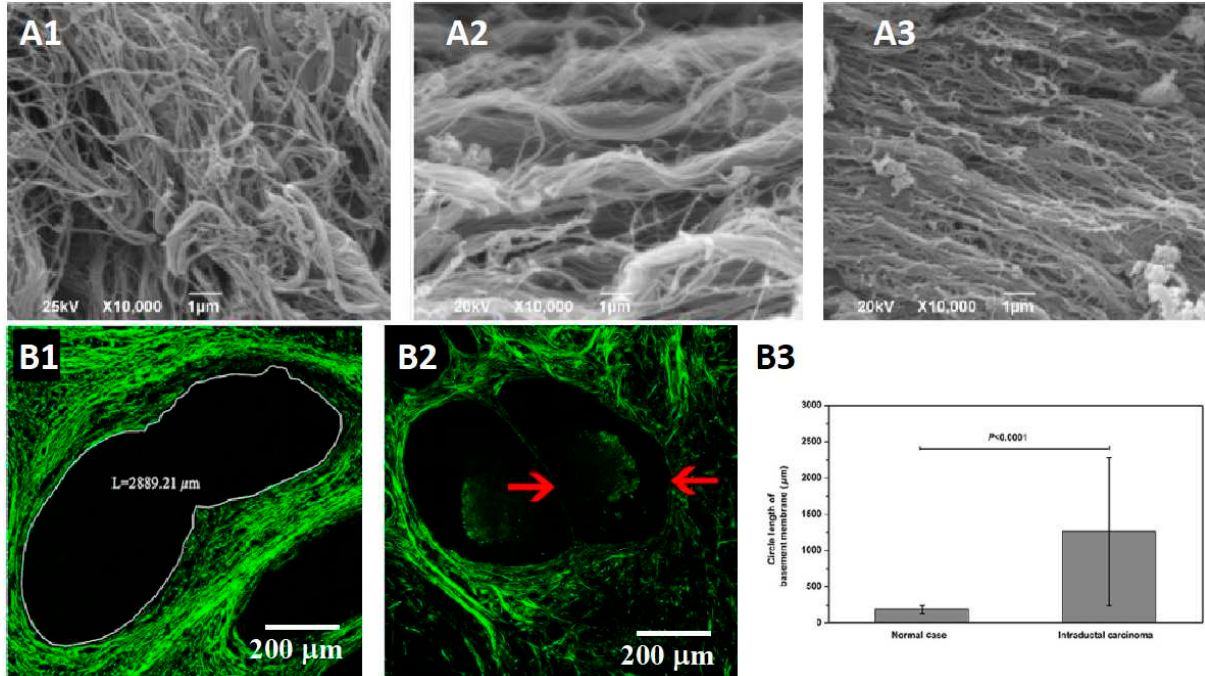
Figure 2. Collagen remodeling in precancerous lesions is a signal of cancerization. ( A1 – A3 ) The SEM images of collagen fibers in the health tissue and 10 cm and 20 cm away from the malignant tumor [39] ( A1 ) The collagen fibers in the health tissue are thin collagen fibers forming a dense network. ( A2 ) The collagen fibers at 20 cm away from the tumor, thick and aligned. ( A3 ) The collagen fibers at 10 cm away from the tumor, highly aligned. ( B1 – B3 ) The difference of base membrane in intraductal carcinoma, a precancerous lesion of invasive ductal carcinoma [44] ( B1 ) The base membrane shows a distorted structure with a larger size. ( B2 ) The base membrane is destroyed in the evolution from intraductal carcinoma to invasive ductal carcinoma. ( B3 ) The statistics data of the circle length of base membrane. The circle length is elongated observably in precancerous lesions compared with normal cases.